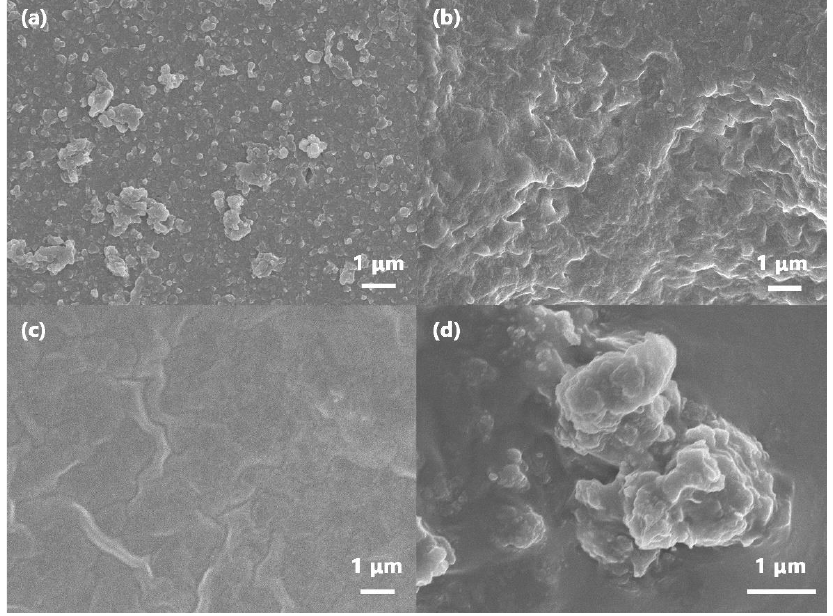
Figure 4. The SEM images of PDA materials after ( a ) 0.5 h, ( b ) 1 h, ( c ) 2 h and ( d ) 4 h reaction.